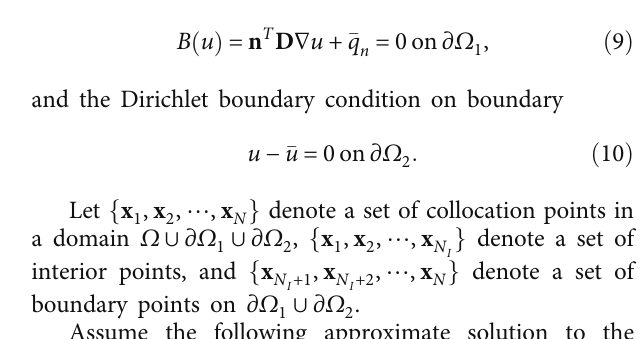
Table 1: Typical RBF and their